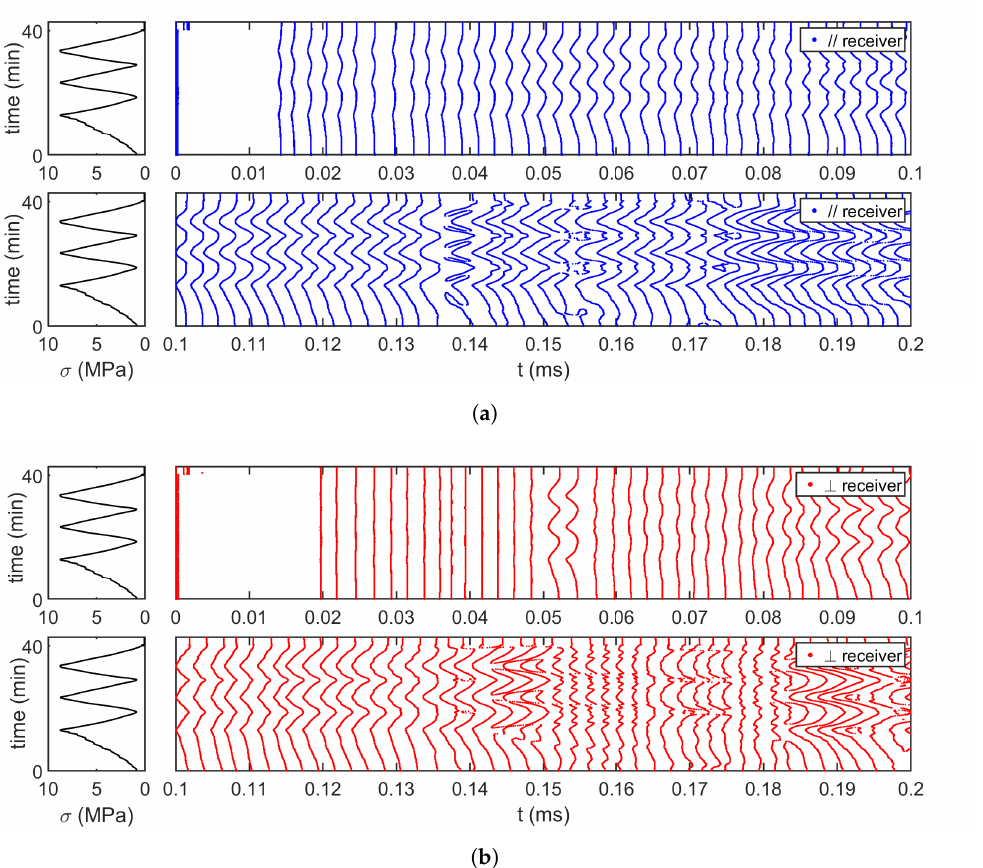
Figure 12. Zero-cross images of ultrasonic signals show time shifts in the parallel direction and transverse direction with uniaxial stress change. The horizontal axis represents signal time, and the vertical axis represents load steps for a duration of 40 min, with corresponding stress on the left. ( a ) Parallel direction; ( b ) Transverse